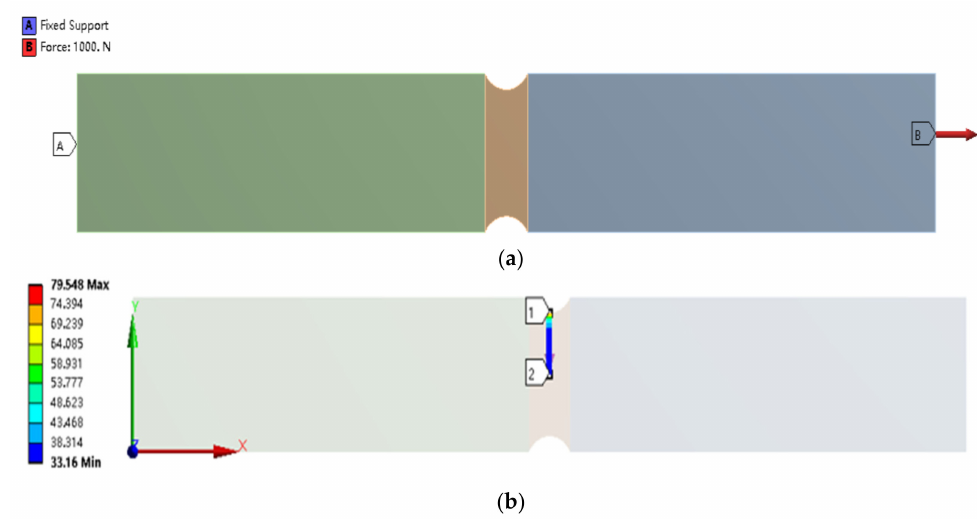
Figure 6. Simulation of the component with a semicircular notch: ( a ) finite element model; ( b ) specified path.